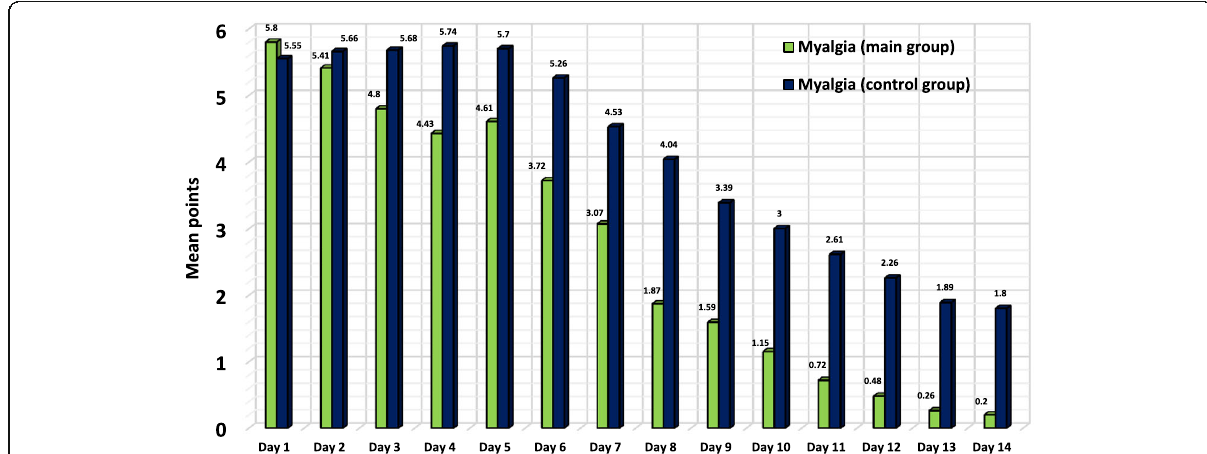
Fig. 2 Myalgia severity dynamics in the groups according to the self-assessment